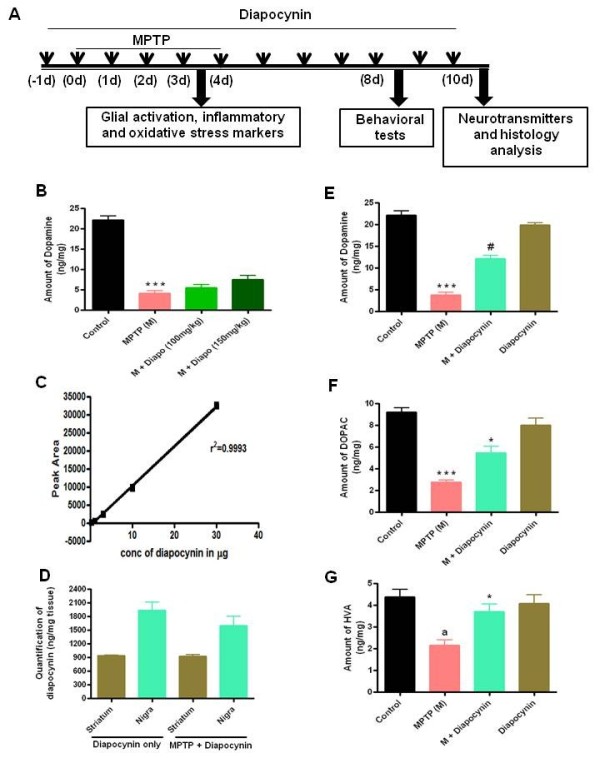
Diapocynin enters brain and attenuates MPTP-induced depletion of neurotransmitters. (A) Treatment schedule of MPTP-injected mice with diapocynin. (B) Mice were treated with two doses of diapocynin (100 and 150 mg/kg/day) and seven days after the last dose of MPTP treatment, striatal dopamine level was measured using high-performance liquid chromatography (HPLC). Quantification of diapocynin in the substantia nigra (SN) and striatum of mice. Mice were administered diapocynin (300 mg/kg/day) by oral gavage 24 h before MPTP treatment, and co-treatment with MPTP (25 mg/kg/day) was continued for 5 days, and post-treatment with MPTP (25 mg/kg/day) lasted 6 days. Seven days after the last injection of MPTP, SN and striatum were dissected out and quantified for diapocynin. (C) Standard curve of diapocynin standards ranging from 0.3 μg to 30 μg. (D) Quantification of diapocynin in SN and striatum. Seven days after the last MPTP treatment, striatal (E) dopamine, (F) 3,4-dihydroxyphenyl-acetic acid (DOPAC) and (G) homovanillic acid (HVA) were measured by HPLC. Data are means ± SEM of eight to ten mice per group. ***P <0.001 versus the control group; *P <0.05 vs the MPTP group; #P <0.01 vs the MPTP group; aP <0.01 vs the control group.